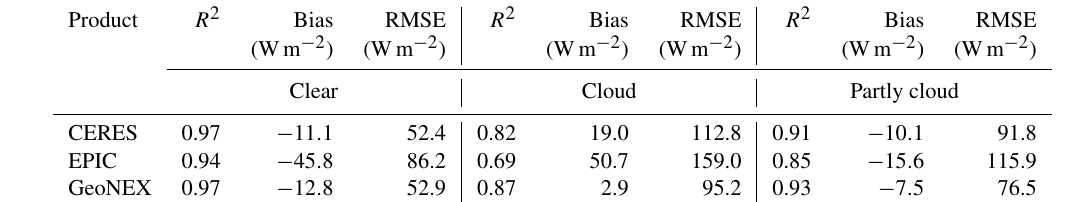
Table 3. Comparison of the GeoNEX DSR product with other DSR products under different cloud conditions.